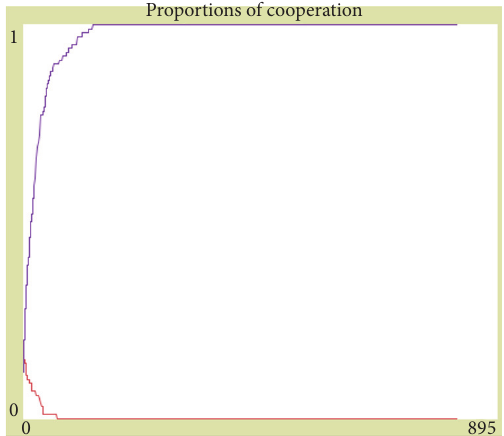
Figure 6: Simulation on knowledge workers’ CWB when 𝑒 < (𝑔 + 𝑡)𝑜 .